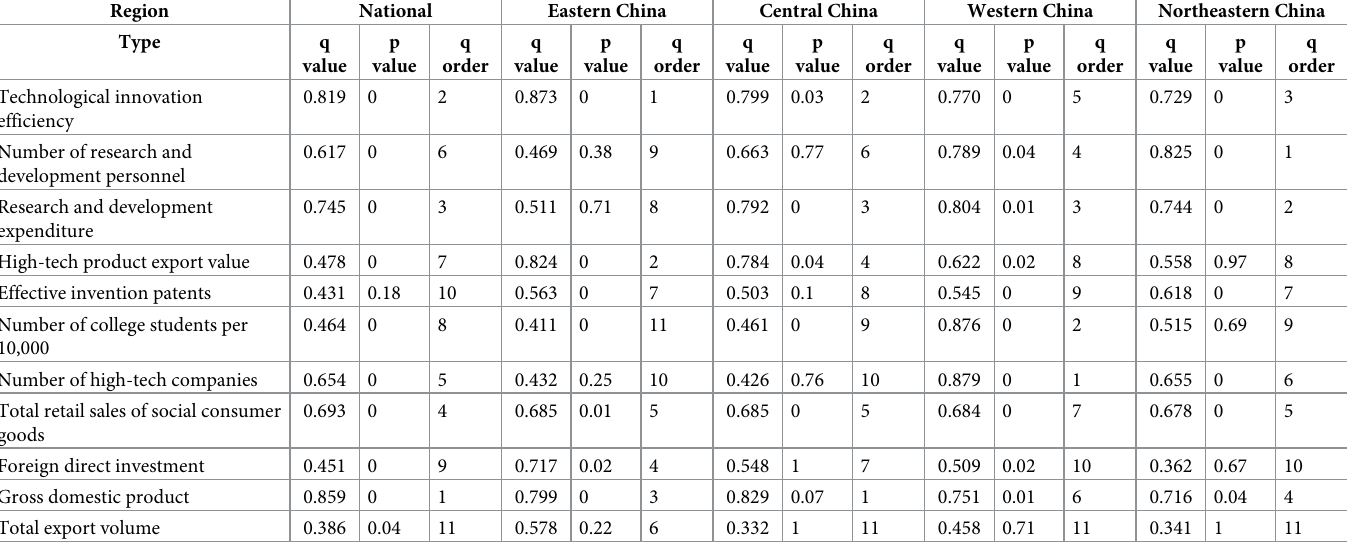
system. The five most influential factors for the degree of coupling between China’s provin- cial complex system were the gross domestic product, efficiency of technological innovation, research and development expenditure, total retail sales of social consumer goods, and the Table 5. Dominant factors in the degree of coupling between the provincial high-tech industry and the regional economy of composite systems. Region National Eastern China Central China Western China Northeastern